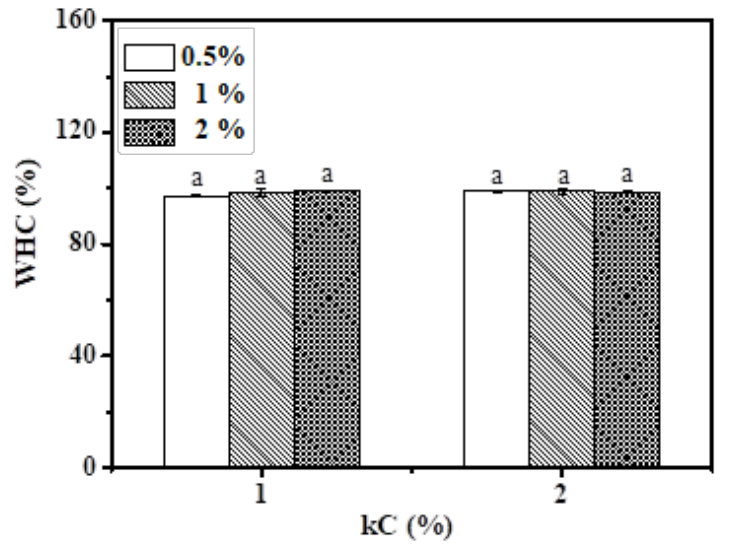
Figure 9. The water-holding capacity of Pickering emulsion gels. Different letters represent significant differences ( p ≤ 0.05).